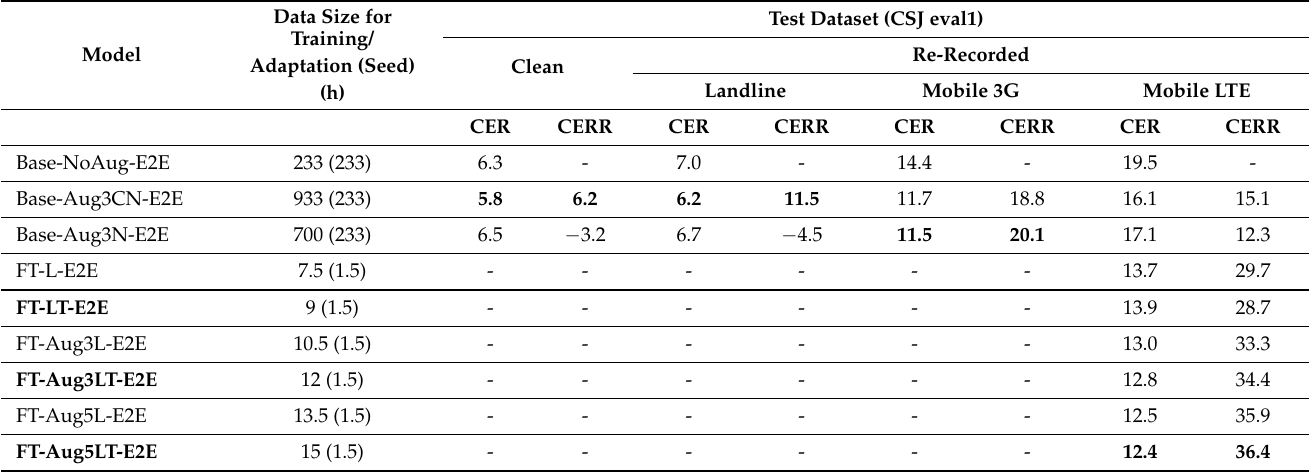
Table 6. Telephone speech: character error rate (CER%) of different E2E ASR models and character error reduction (CERR%) from Base-NoAug-E2E. The notation “-” denotes “not applicable”. The expressions with bold font represent the models trained with proposed fine-tuning method. The bold numbers represent the best result for each test